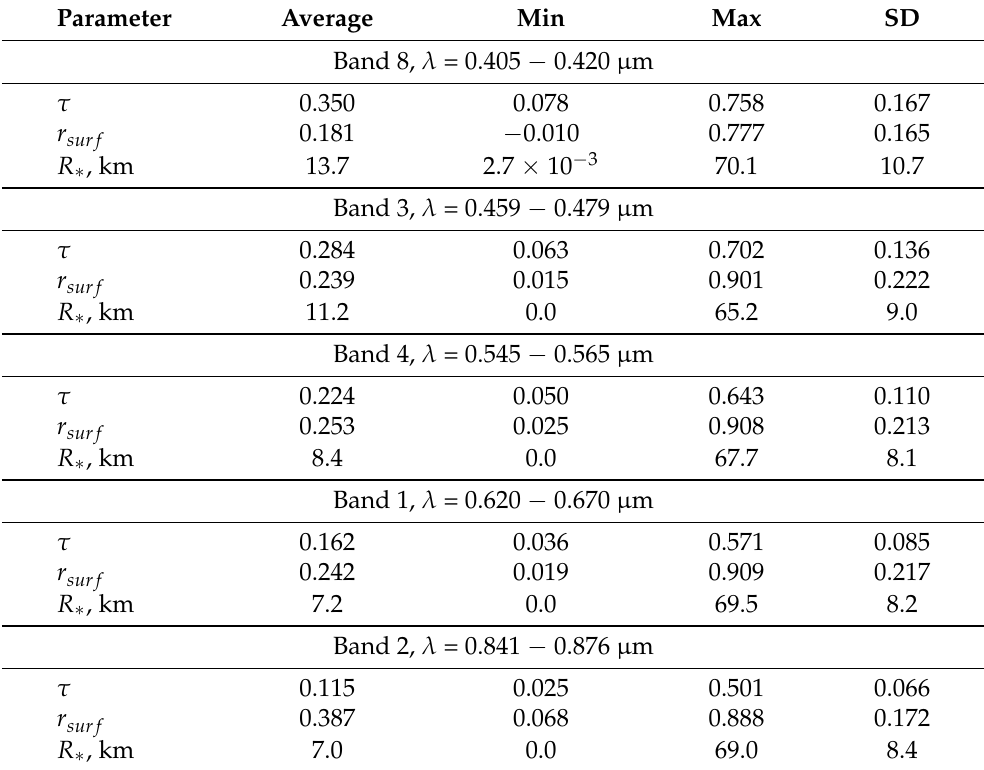
Table 2. Values of τ , r surf , and R ∗ for the considered images in different MODIS bands.